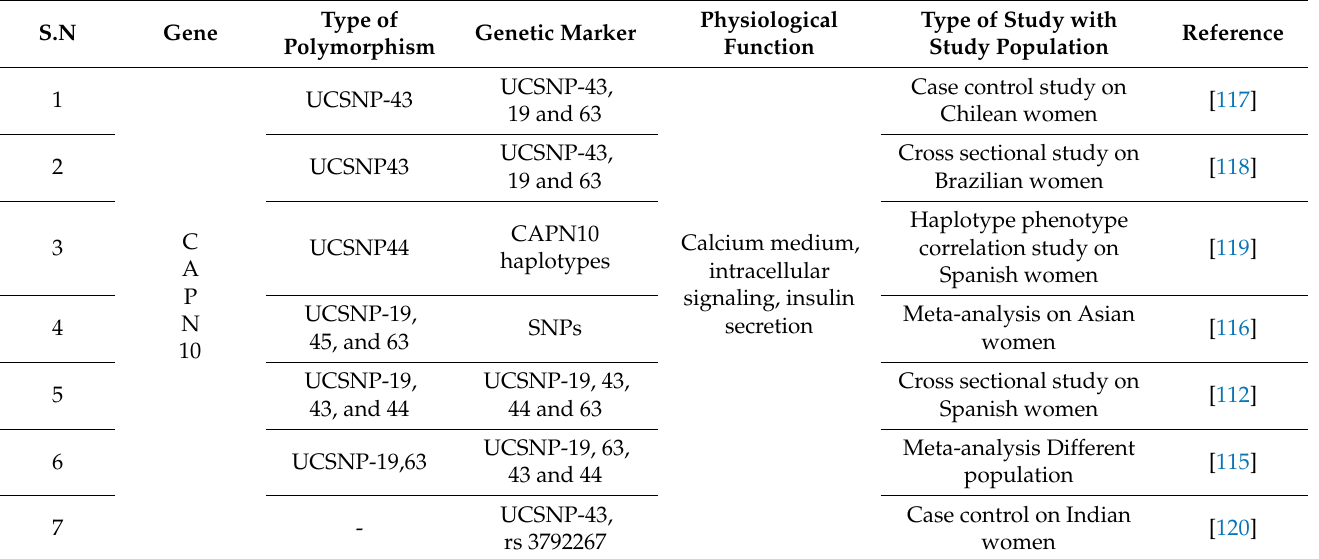
Table 5. Polymorphism Associated with Calpain 10